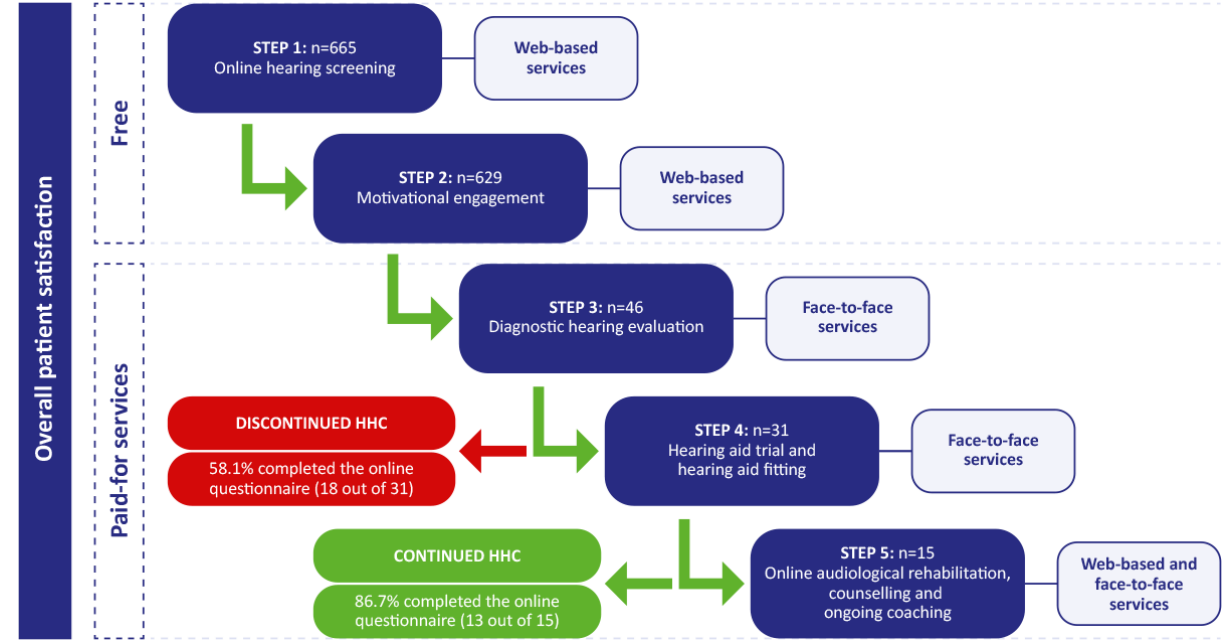
Figure 1. Five steps in a hybrid (Web-based and face-to-face) hearing health care (HHC) service-delivery model.